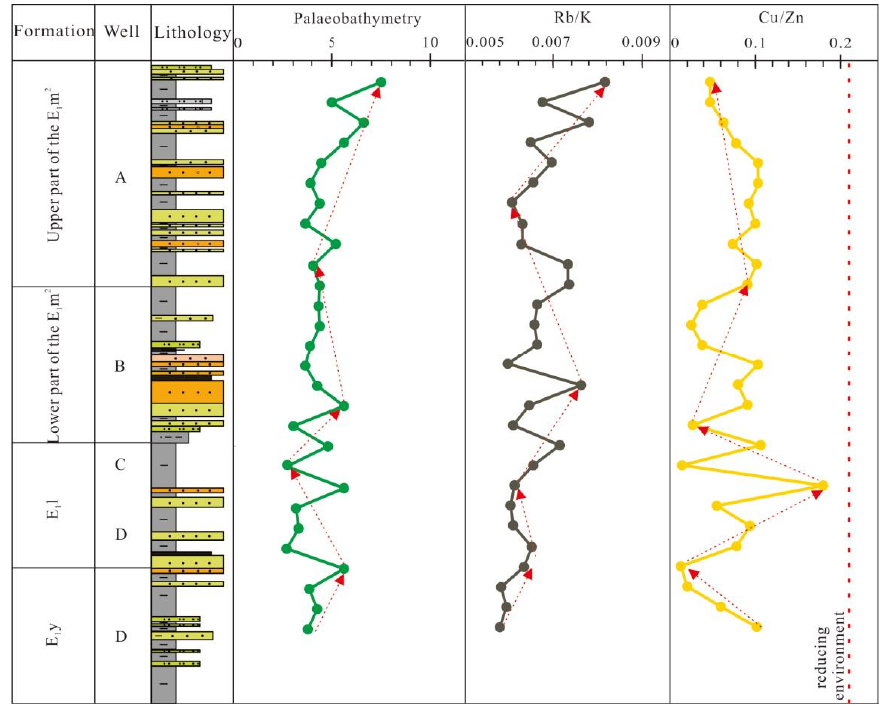
Figure 14. The relationships between Cu/Zn and paleobathymetrics of the Paleocene in the West Lishui Sag.